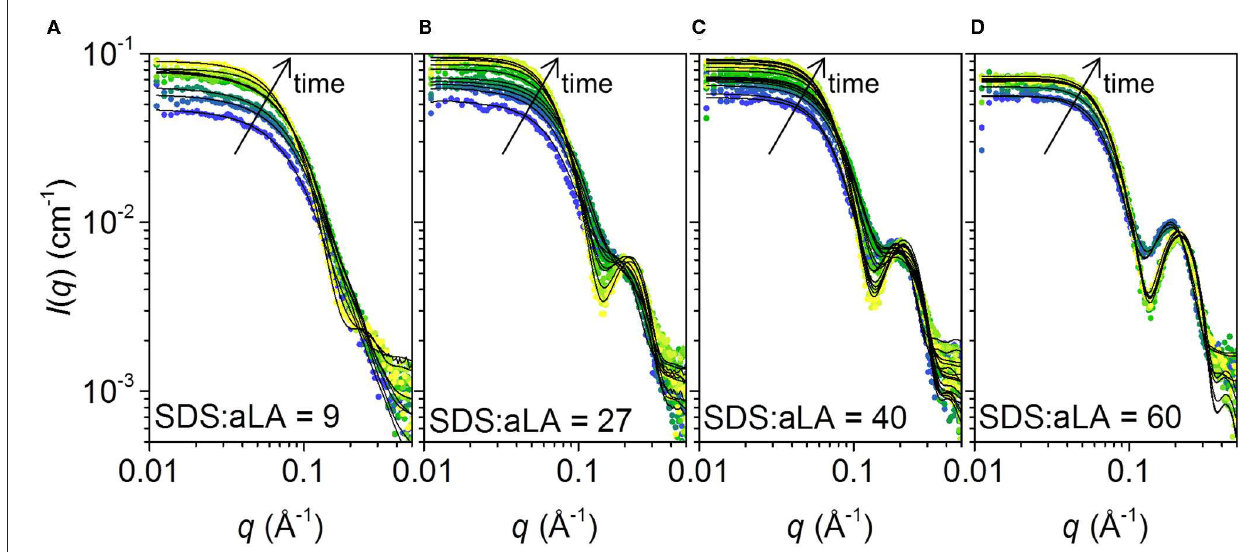
FIGURE 5 | (A–D) Stopped-flow SAXS data plotted as scattering intensities vs. the momentum transfer q , collected after mixing SDS and aLA solution to obtain SDS:aLA ratios of 9, 27, 40, and 60, respectively. Time increases from blue to yellow. Selected data sets are shown. Corresponding staggered plots are shown in the SI ( Figure S1 ) for better comparison of data and